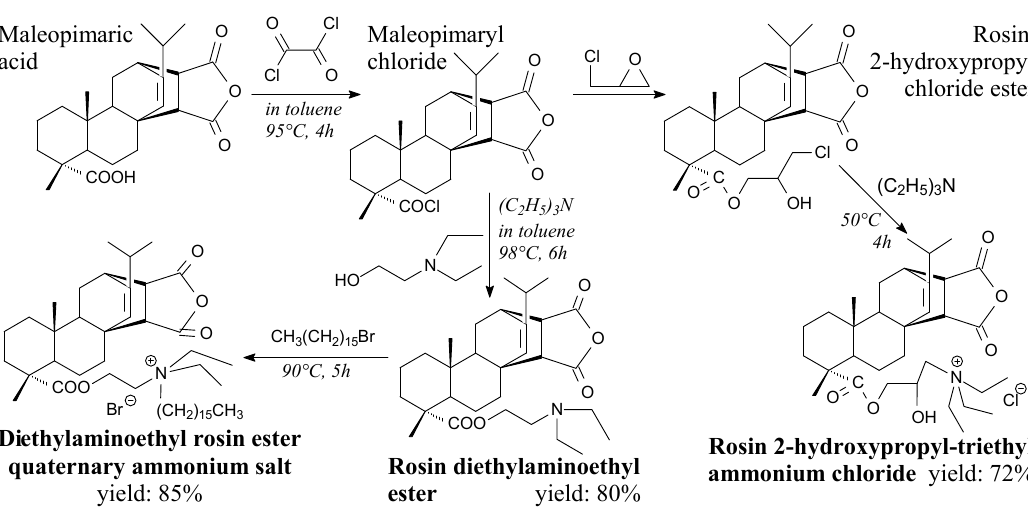
Scheme 30. Synthesis of quaternary ammonium salts of rosin esters.